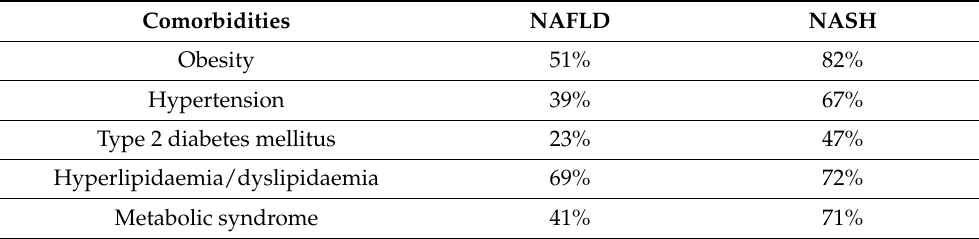
Table 3. Comorbidities associated with NAFLD and NASH, respectively, based on a meta- analysis